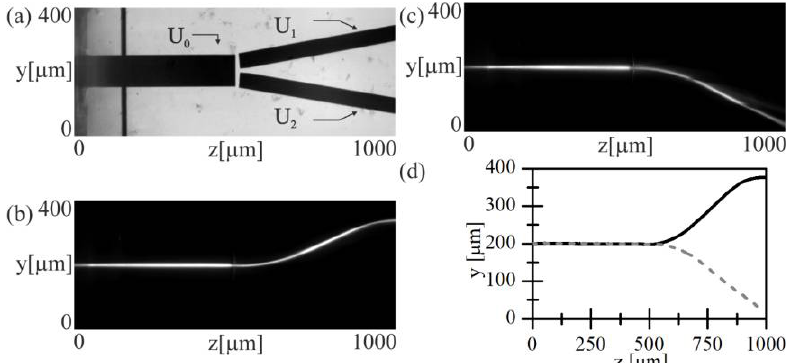
Figure 8. Combination of three independent powered electrodes of a width of 100 and 50 μm that formed an optical Y-junction for TM-polarized beam: ( a ) Electrodes within NLC cell. ( b ) Nonlinear propagation of a beam at λ = 1064 nm and optical power P = 1.5 mW for biasing voltage of U 0 = U 1 = 2.1 V and ( c ) U 0 = U 2 = 2.1 V. ( d ) Corresponding to ( b , c ) beam trajectories—black solid to light gray dashed line, respectively.